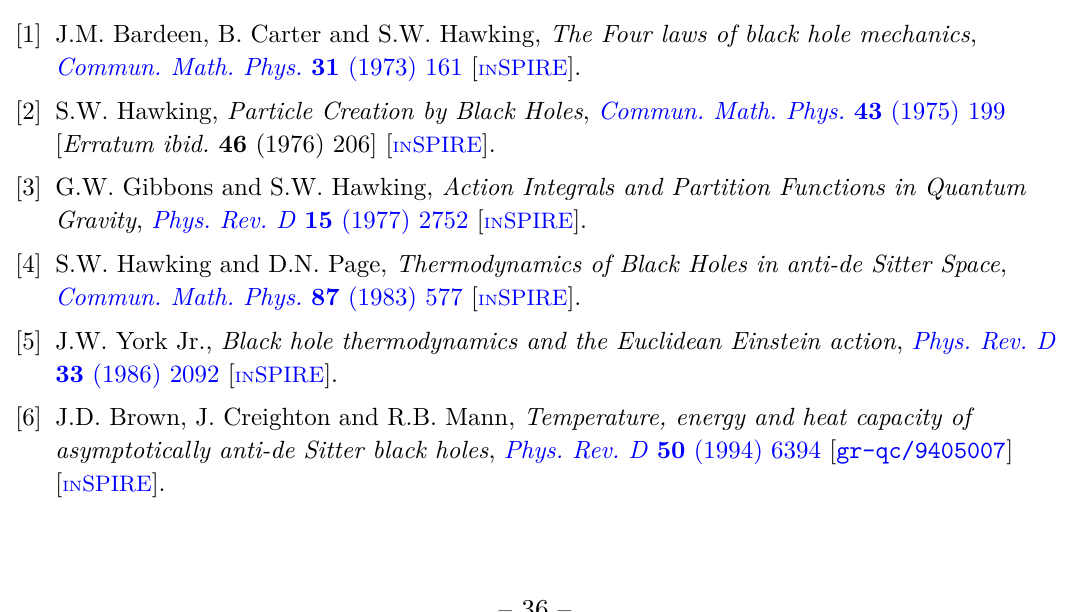
Figure 28 . Solutions f, ϕ, δ of Euclidean PL-BH and PL-BG instanton when r H = 4 √ ϕ H = 2 . 7 G for the former and r H = 6 resents the position of the boundary. r √ latter. ( r = 5 G, Λ = − 0 . 04 /G, M = 0 . 1 / b Open